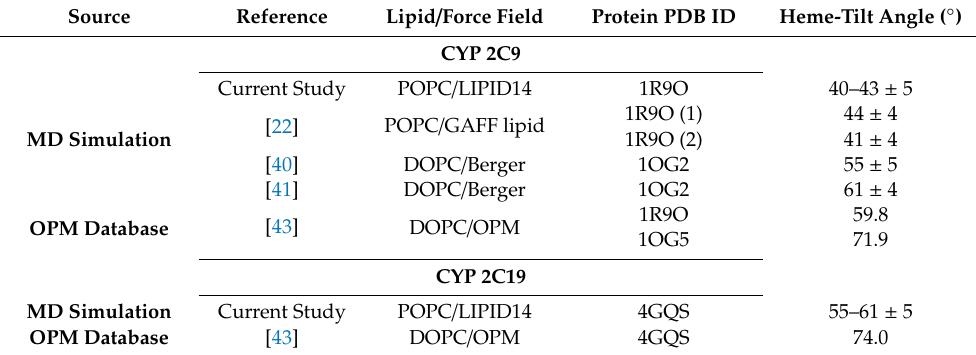
Table 3. Comparison of the computed heme-tilt angle from AA MD simulations of CYP 2C9 and CYP 2C19 with previously reported values. The heme-tilt angle is the angle between the heme plane and the membrane normal (see Materials and Methods and Figure